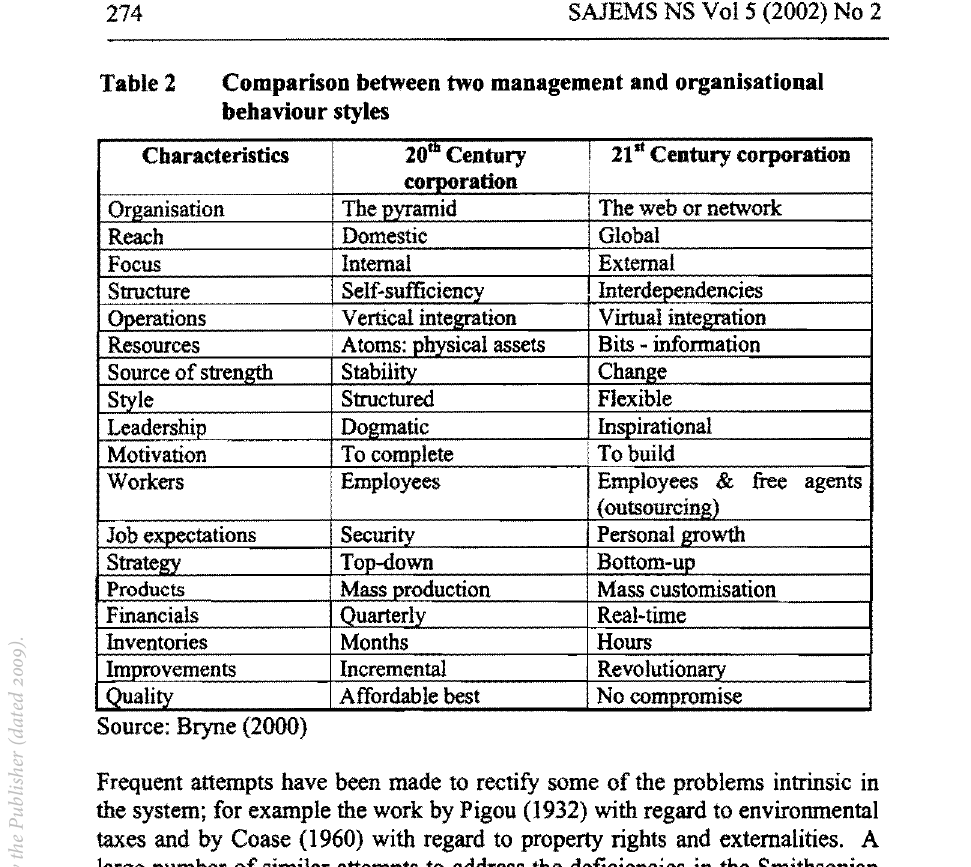
Comparison between two management and organisational behaviour